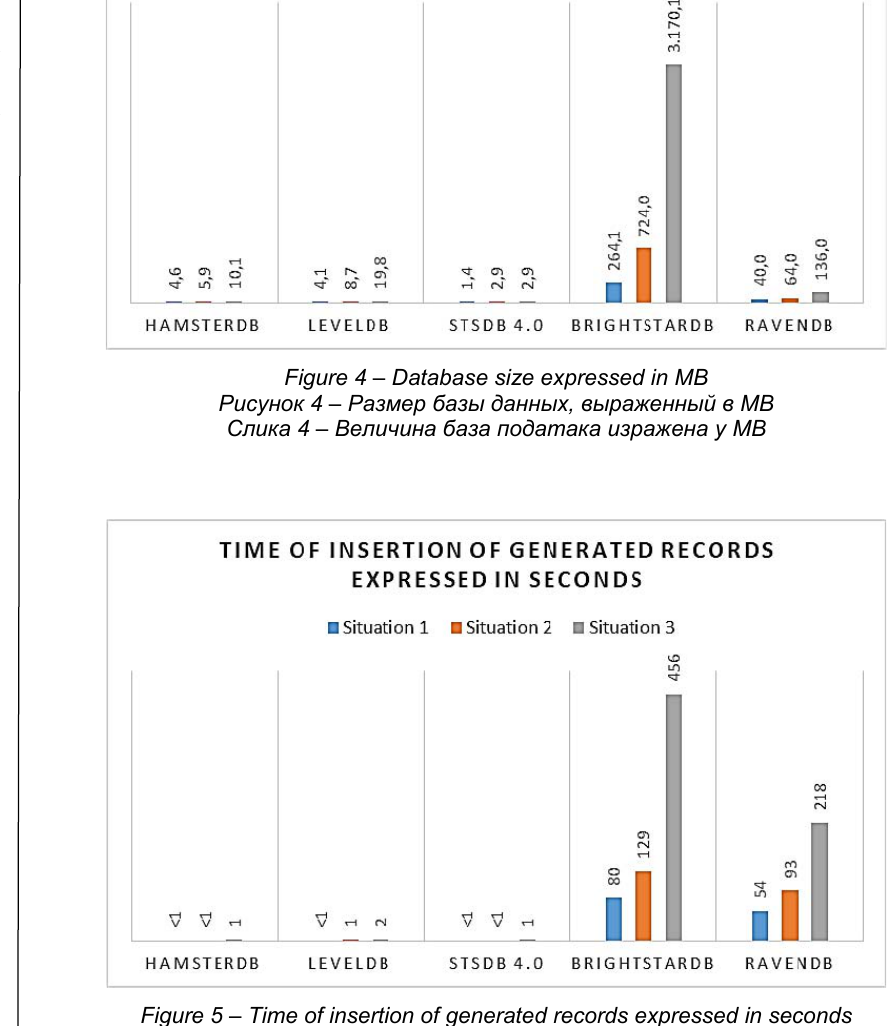
Figure 5 – Time of insertion of generated records expressed in seconds Рисунок 5 – Время вставки сгенерированных записей , выраженное в секундах Слика 5 – Време уметања генерисаних записа изражено у